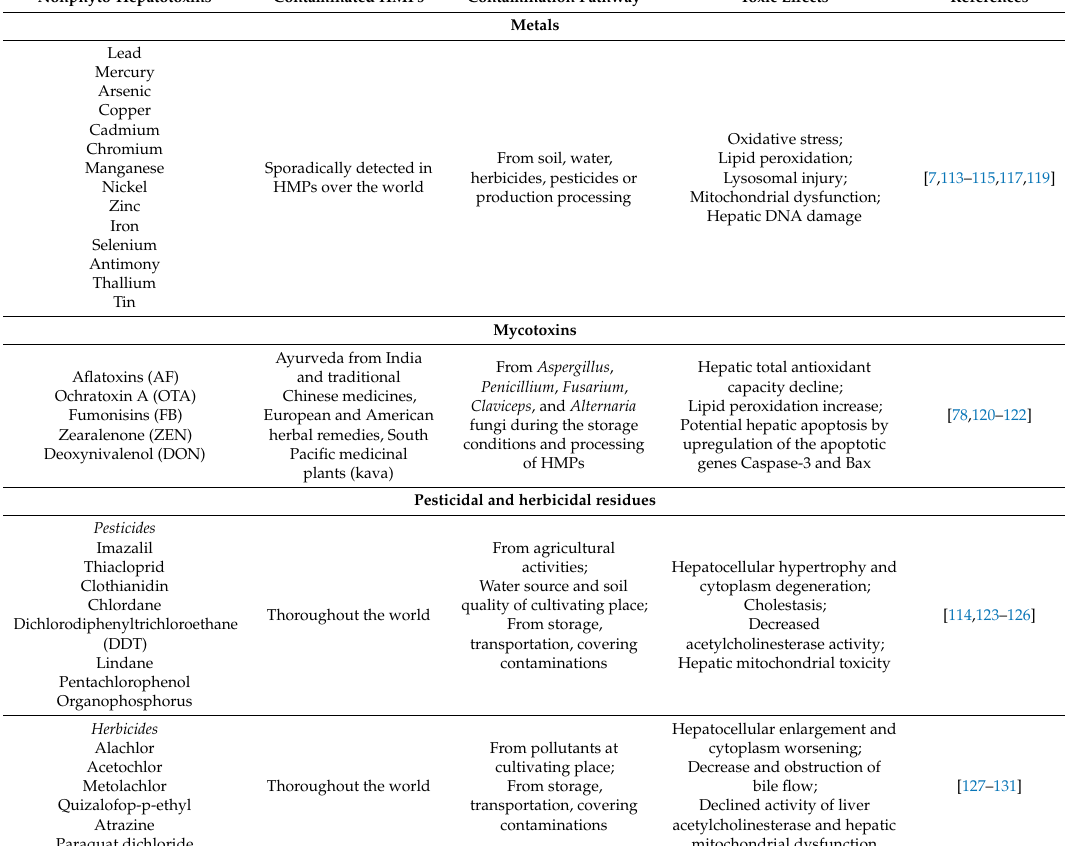
Table 2. Suspected nonphyto-hepatotoxins found in herbal medicinal